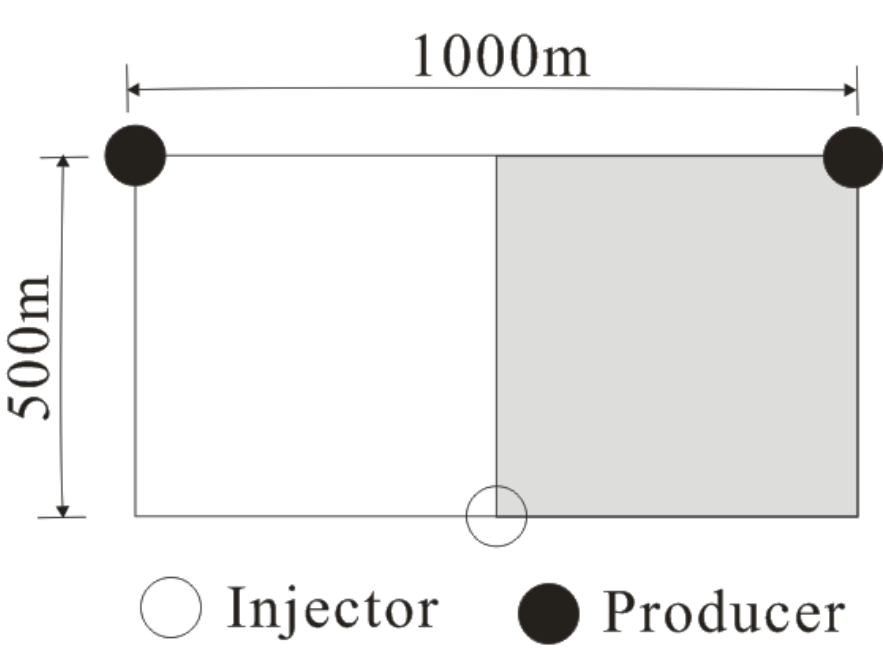
Figure 2. The EGS of three horizontal wells.